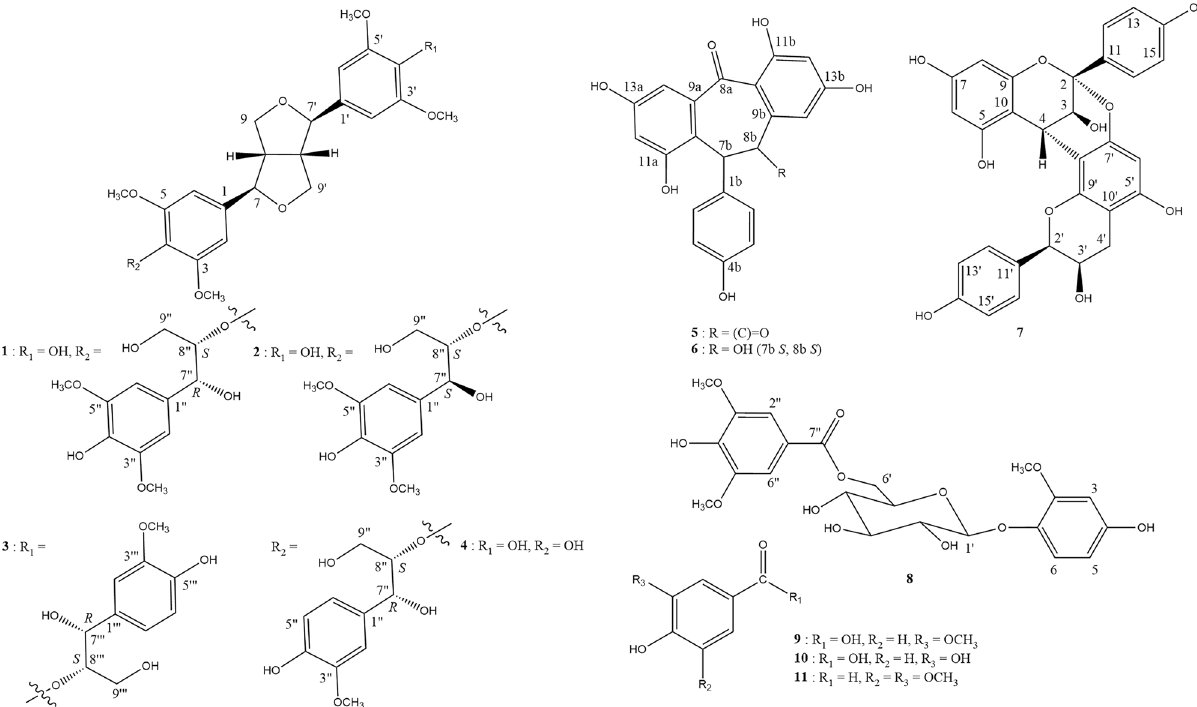
Figure 1. Compounds isolated from EtOAc extract of C. brachiata stem and bark. (−)-(7 ′′ R ,8 ′′ S )-buddlenol D ( 1 ), (−)-(7 ′′ S ,8 ′′ S )-buddlenol D ( 2 ), (+)-7 ″ R ,8 ′′ S :7 ″′ R ,8 ′′′ S -hedyotisol A ( 3 ), (−)-syringaresinol ( 4 ), (+)-diptoindonesin D ( 5 ), (+)-parviflorol ( 6 ), (−)-mahuanin A ( 7 ), 6- O -syringoyl-β-d-glucopyranoside derivative ( 8 ), vanillin ( 9 ), protocatechuic acid ( 10 ), and syringaldehyde ( 11